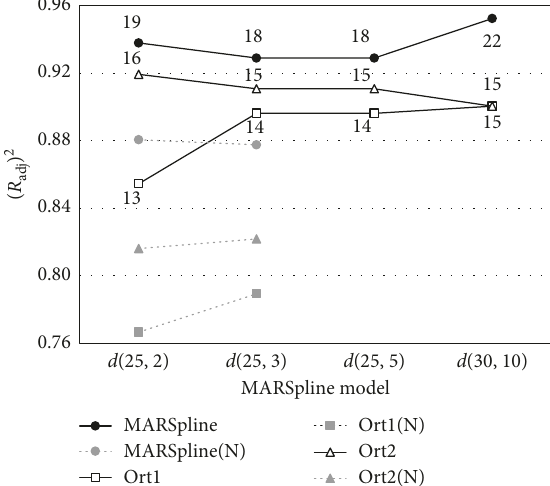
Figure 1: Results of predicting the values of the d descriptor, based on a series of d ( b , i ) MARSplines models characterized by number of initial basis functions ( b ) and allowed maximum interactions ( i ). Provided numbers represent amounts of factors used in the final regression function with statistically significant contributions. Grey lines represent results obtained after normalization of each of the descriptor distributions, while black lines correspond to models built on absolute values of